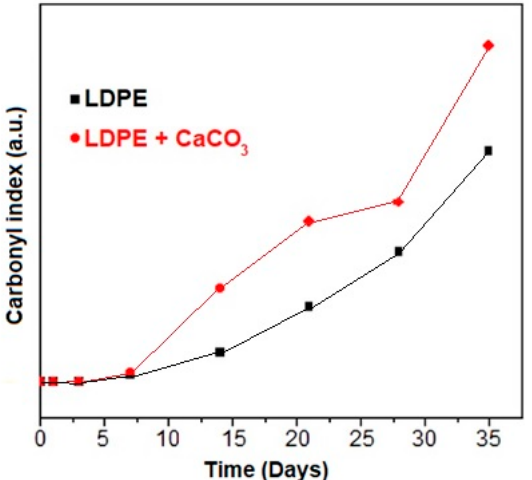
Figure 5. Carbonyl index (CI) of neat LDPE and LDPE/CaCO 3 at different irradiation times.